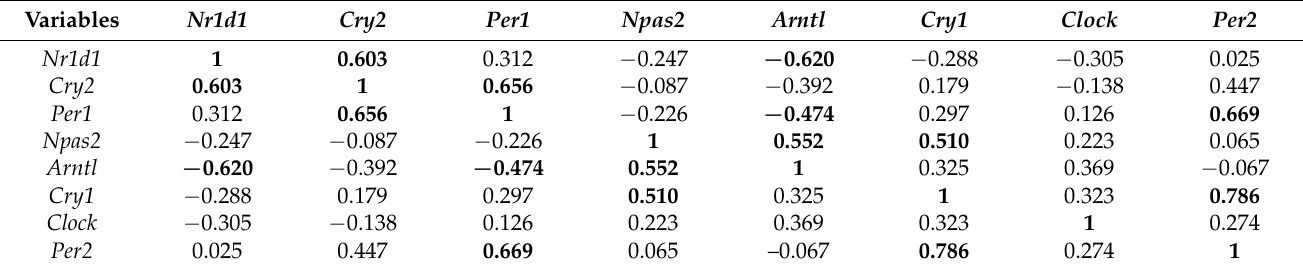
Table 2. Pearson pairwise correlation matrix; df =